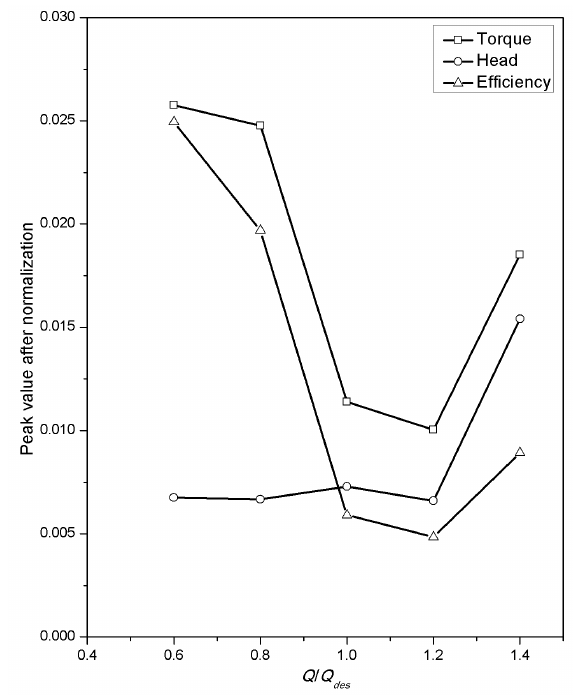
Figure 9. Dimensionless peak values after the process of normalization. Q : volume flow rate (m 3 ·s −1 ) The curve of the normalized peak value of the head has completely different characteristics from the other two curves (as shown in Figure 9). This is because there is little change before the flow